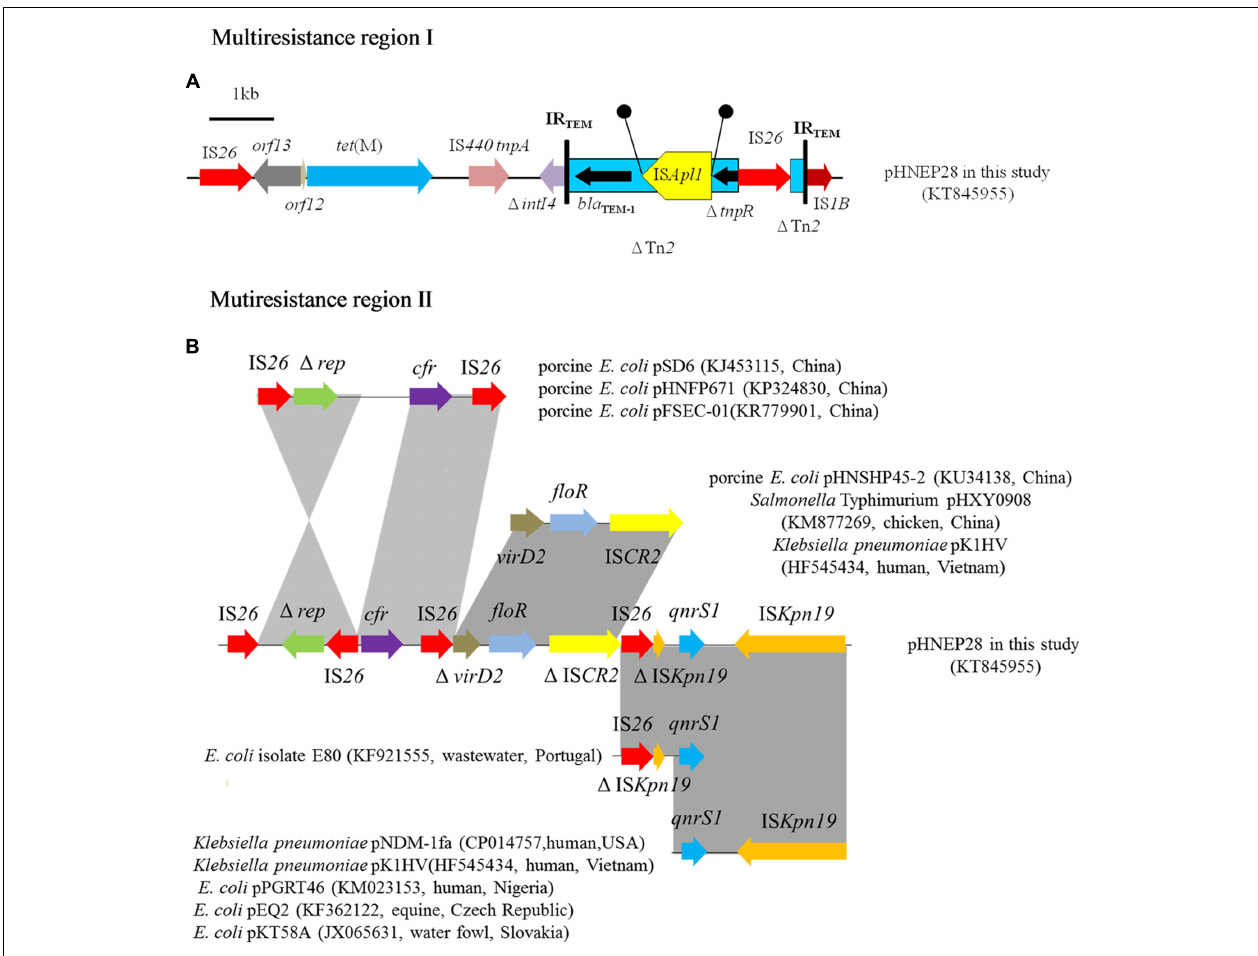
FIGURE 2 | Multiresistance regions in plasmid pHNEP28. The arrows indicate the positions and transcription directions of the genes. Regions with > 99% homology are shaded in gray. (cid:49) indicates a truncated gene. Black circles mean direct repeats generated by the insertion of IS Apl1 . (A) Multiresistance region I in plasmid pHNEP28 (B) Mutiresistance region II in plasmid pHNEP28 and the structural comparison with other plasmids.